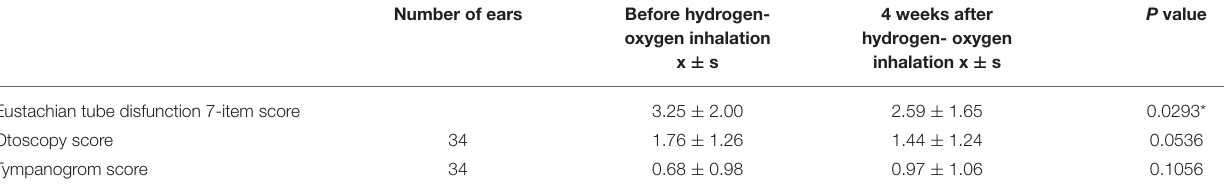
TABLE 2 | Eustachian tube dysfunction 7-item score, otoscopy score and tympanogram score.